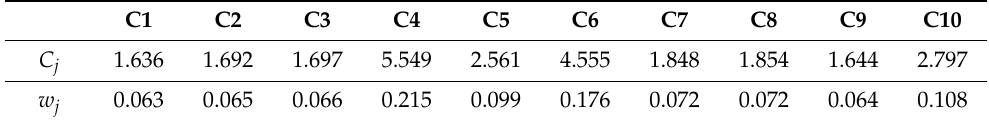
Table 5. Values of C j and weight values of